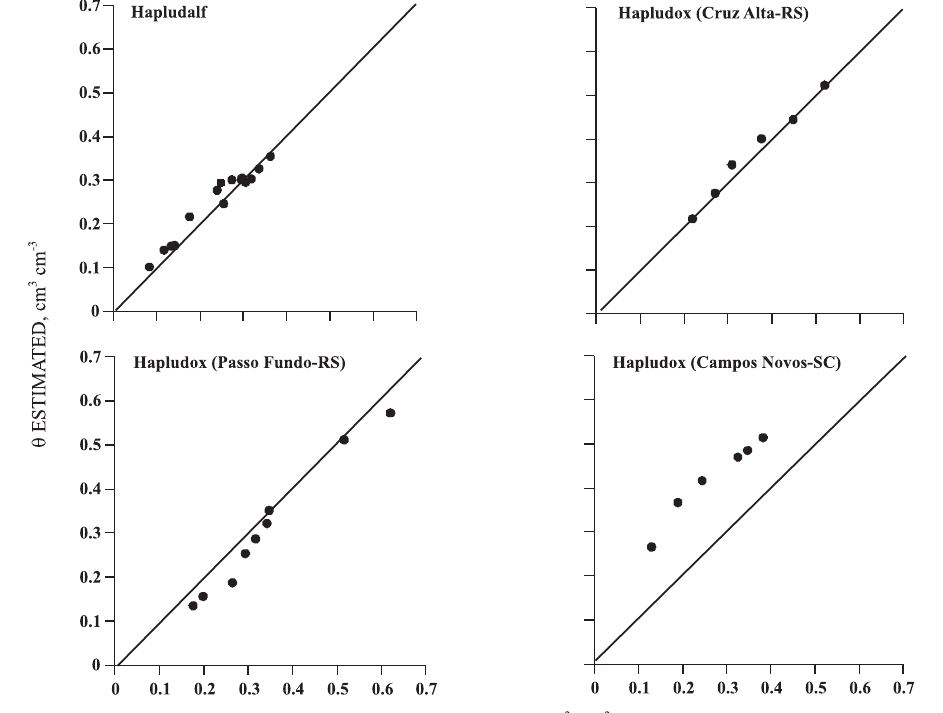
Figure 10. Relationship (1:1 graphic) between the volumetric soil moisture observed and that estimated with the model proposed by Ledieu et al.